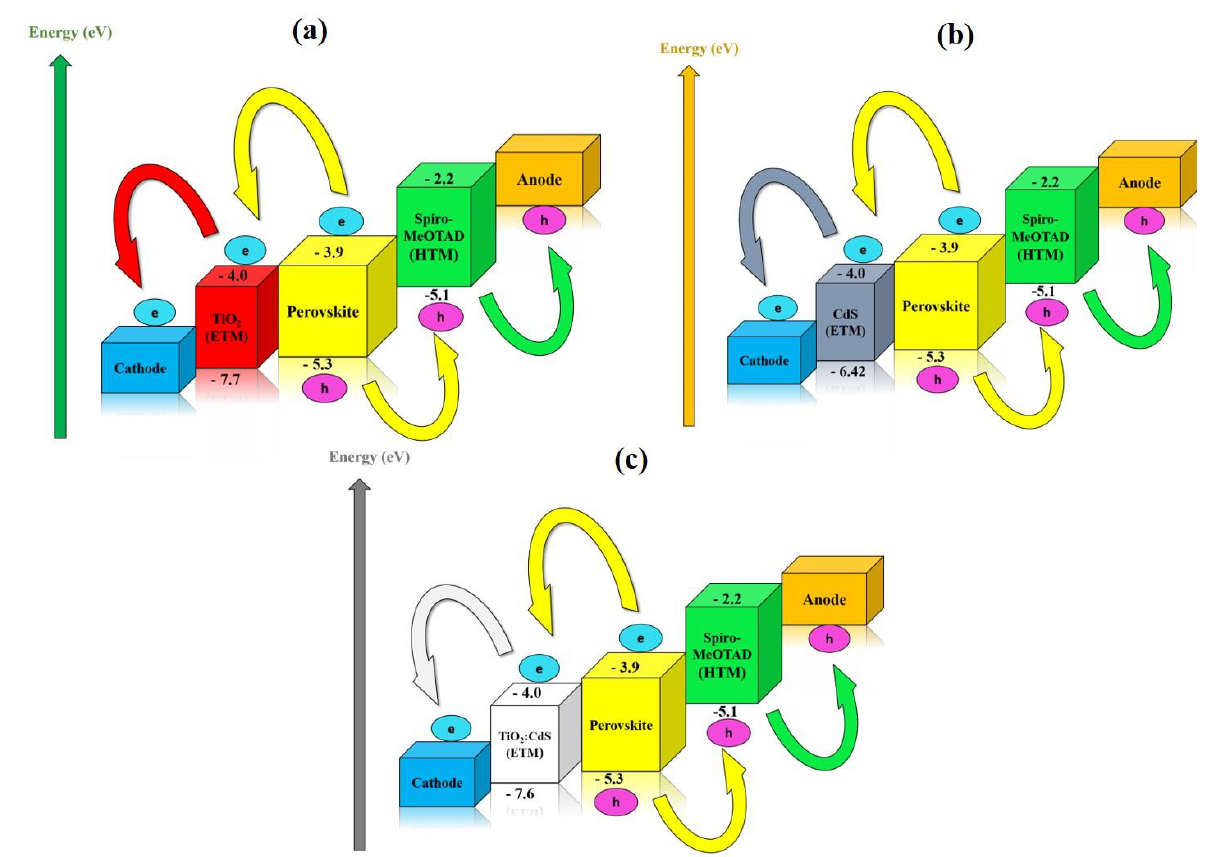
Figure 3. Energy band diagram of PSC with ETM ( a ) TiO 2 , ( b ) CdS, and ( c ) TiO 2 :CdS.